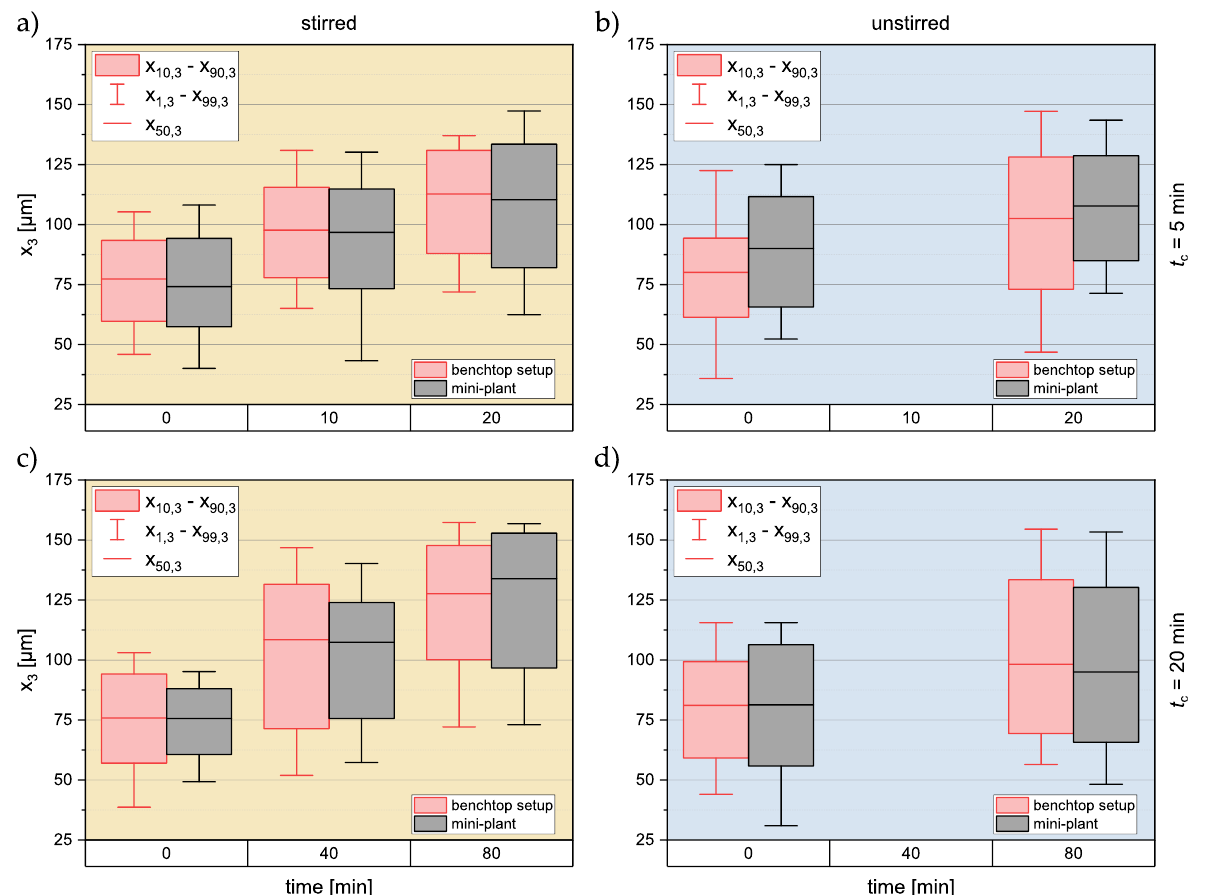
Figure 8. Visualization of the behavior of the CSD along the experiments: stirred and t c = 5min in ( a ); unstirred and t c = 5min in ( b ); stirred and t c = 20min in ( c ); unstirred and t c =20min in ( d ). Each of the experiments was performed in a fourfold manner. To not disturb the process, medium samples have been taken at the beginning and the end of the unstirred